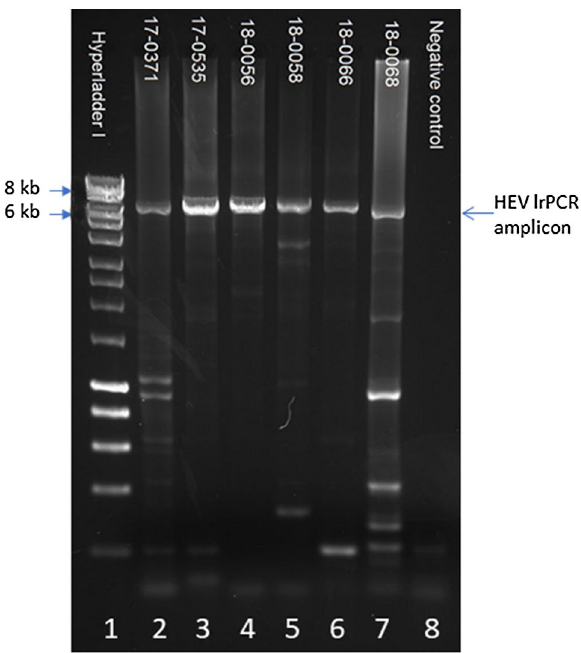
Figure 1. Agarose gel electrophoresis of HEV lrPCRs. Lanes 2–7 show lrPCR results of patient samples 17-0371 to 18-0068 with signals of correct size between 6 and 8 kb. Lane 1: size marker (HyperLadder™ 1 kb, Bioline)(for the creation of the gel image the software BioDocAnalyze, Version 2.67.5.0, www. biome tra. com was used).